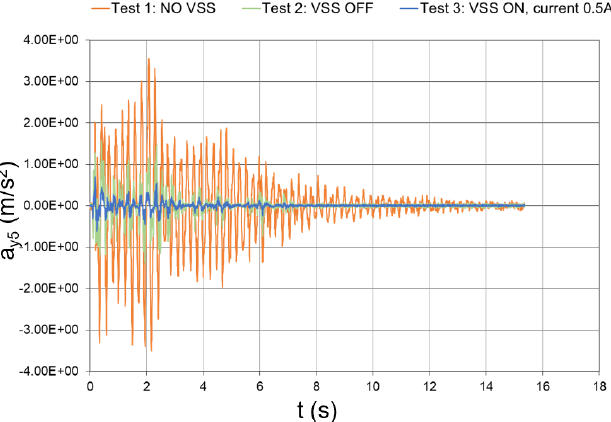
Figure 48. Seismic response, 5th-floor acceleration with respect to the ground (experimental data).